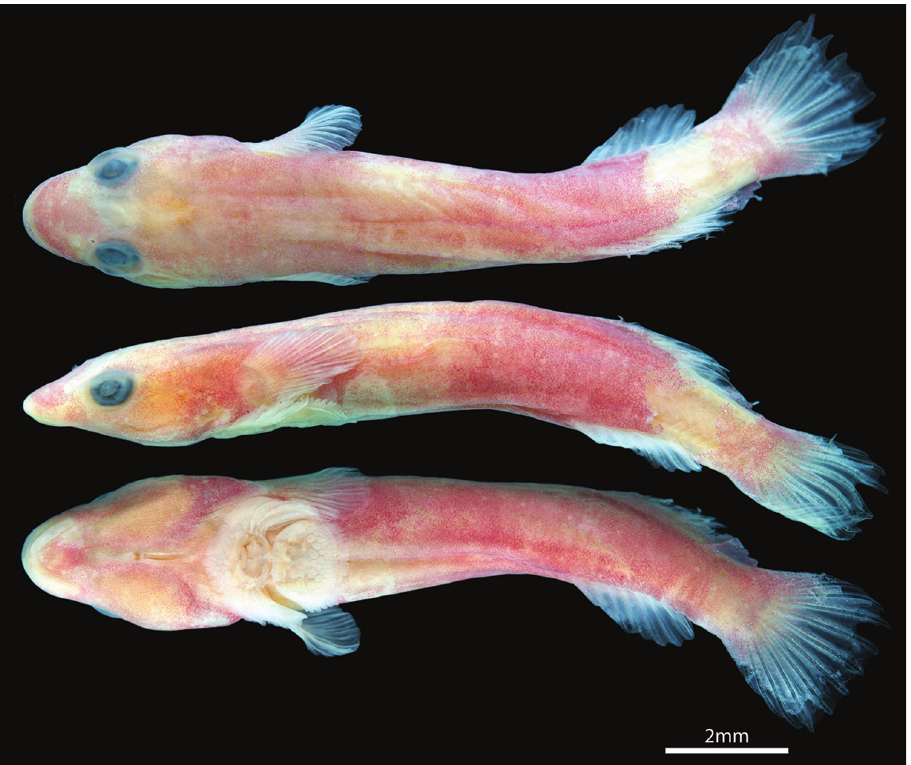
Figure 1. Flexor incus , NMNZ P.060717, holotype, 20.8 mm SL; New Zealand, Kermadec Islands, Raoul